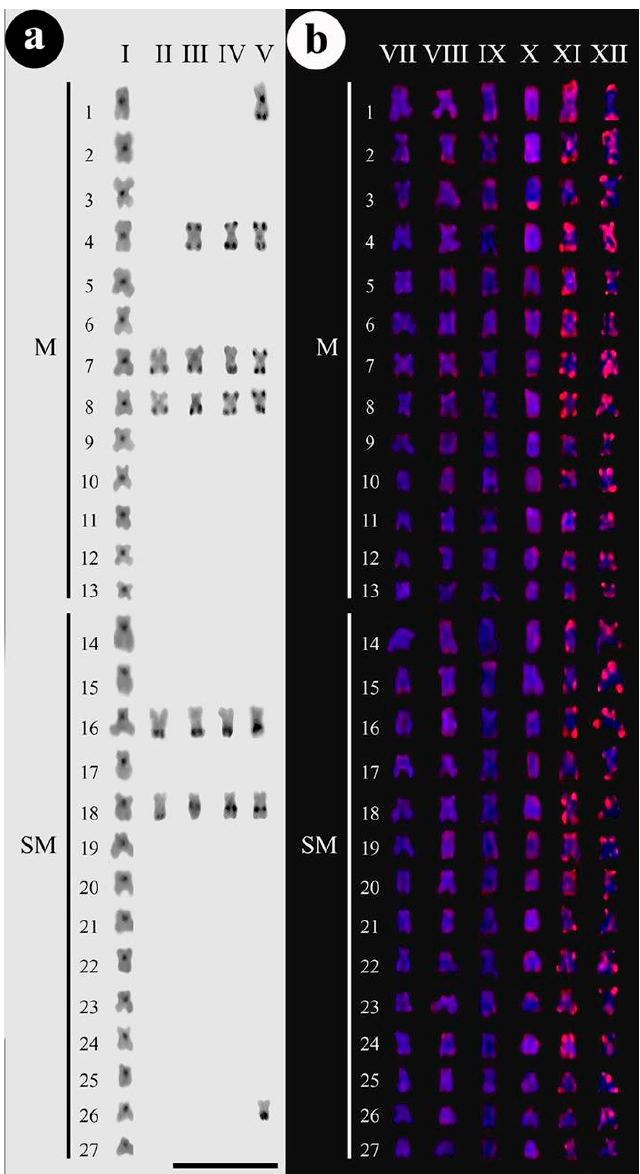
Figure 2. ( a )-I–C-banding of C. macropomum in the control group (C0-0.0 mg/L of Trichlorfon). Het- erochromatic regions are marked in the pericentromeric portions of chromosomes, conventional configuration for C-banding of tambaqui. For details, see references [31–43]. 2( a )-II–C-banding after exposition to trichlorfon to 30% LC 50–96 h -48 h (C1 = 0.261 mg/L). 7, 8, 16, and 18 chromosomes are marked. 2( a )-III–C-banding after exposition to 50% LC 50–96 h -48 h (C2 = 0.435 mg/L), bi- 2( a )-IV-C-banding after exposition to 50% LC 50–96 h -72 h, bi-telomeric markings are